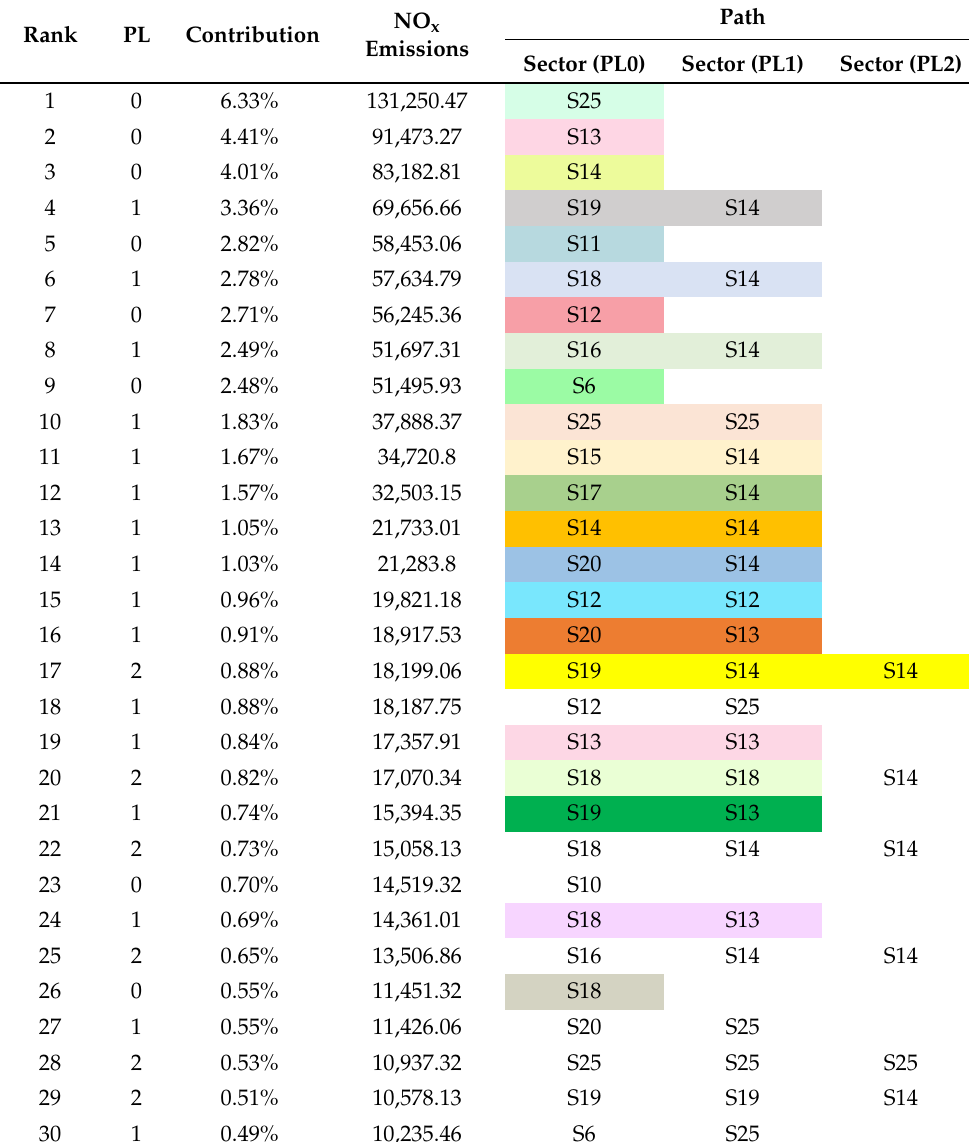
Table 5. The top 30 paths for China’s NO x emissions start with the final demand category and end up in a